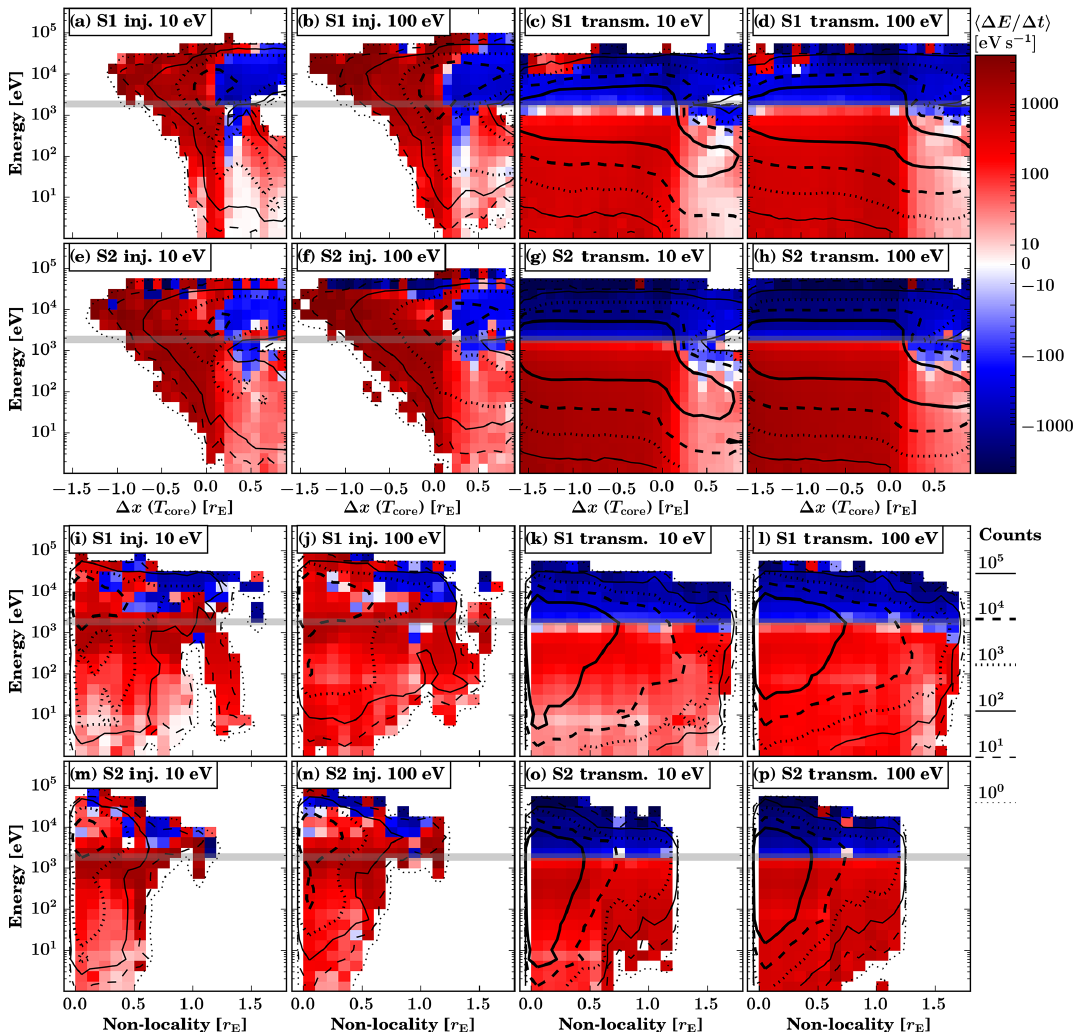
Figure 5. Mean energization experienced by test particles over their shock interaction. Particle energy changes over 0.5s intervals are inte- grated and averaged, recording them always at the pre-interval energy. Energization tracking is performed separately for injected (columns 1 and 2) and transmitted (columns 3 and 4) particles. The top two rows (a–h) track energization as a function of current particle solar wind frame energy and (cid:49)x from the closest position where the solar wind core heating shock criterion is met, and the bottom two rows (i–p) track energization as a function of current particle solar wind frame energy and shock non-locality. Rows 1 and 3 are from Simulation S1; rows 2 and 4 are from S2. Black logarithmic contours indicate the counts of measurements used for evaluating mean energization. A grey band indicates the minimum energy required for propagating upstream against the solar wind flow (1.9keV for 600kms − 1 ). It is important to note that large values of shock non-locality can indicate signals of shock structure downstream as well as upstream of the parabolic shock fit